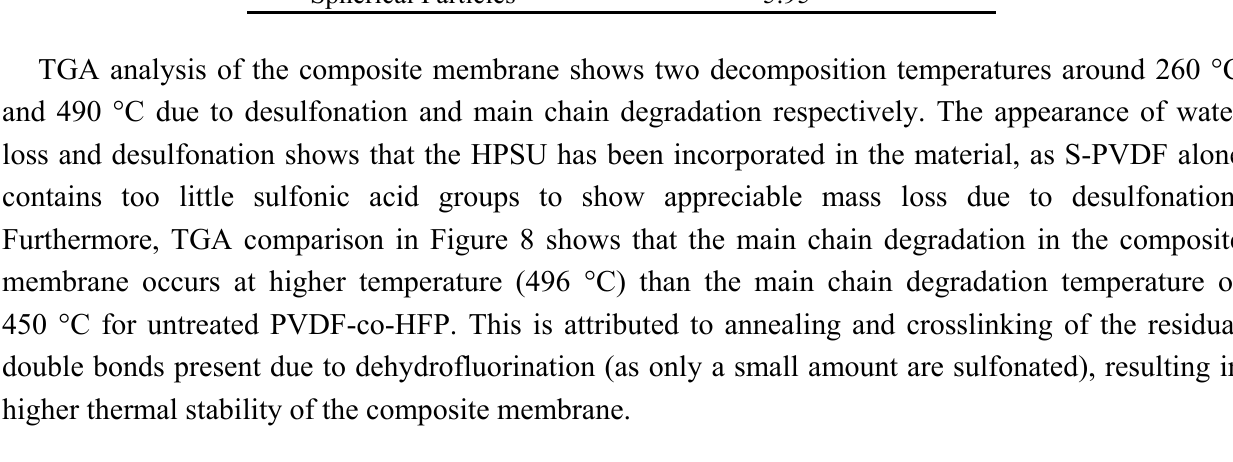
Figure 8. TGA spectra of the blend membrane (20% HPSU) and untreated